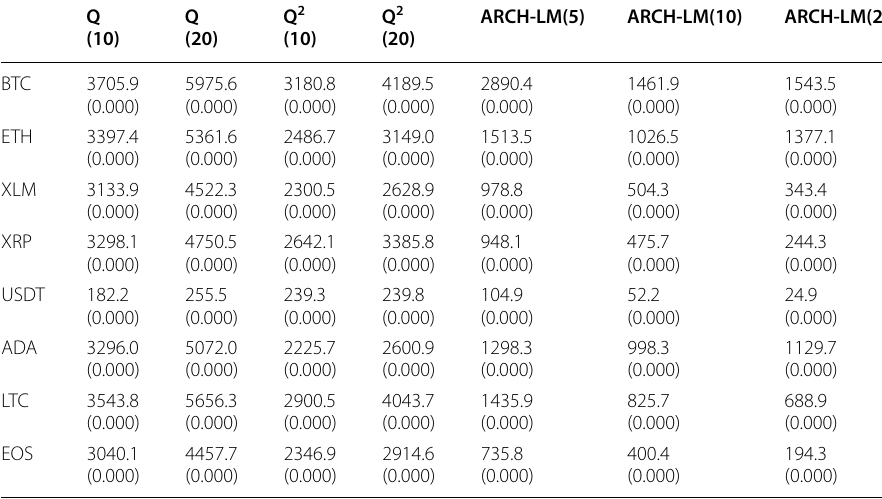
Table 3 Ljung–Box and ARCH-LM